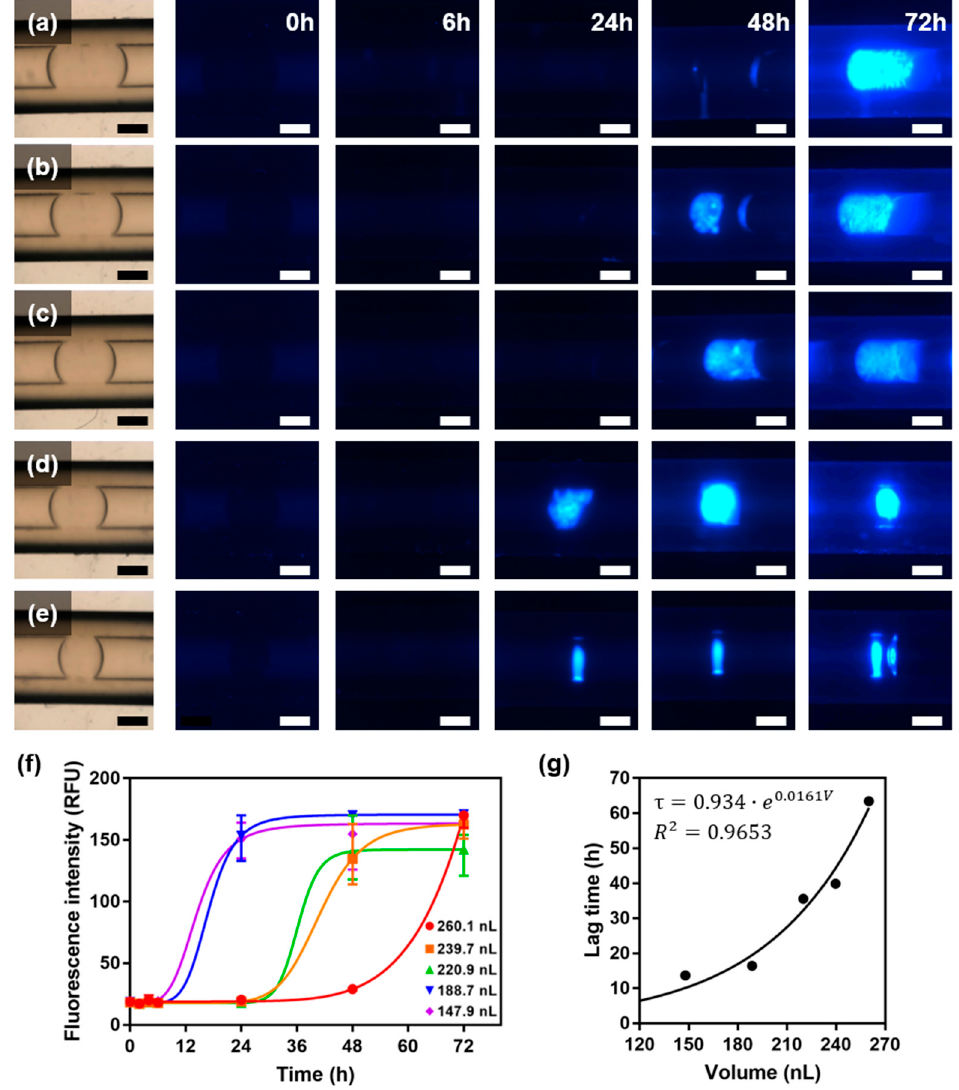
Figure 3. Amyloid fibrillation in nanoliter droplets. Bright-field images of nanoliter droplets based on volume (( a ) 260.1 nL; ( b ) 239.7 nL; ( c ) 220.9 nL; ( d ) 188.7 nL; ( e ) 147.9 nL), and corresponding fluorescence images of nanoliter droplets during incubation. Scale bar is 500 µm. ( f ) ThT fluorescence assay for detection of fibrillation. ( g ) Lag times ( τ ) of amyloid fibrillation in different volumes ( V ) of droplets.